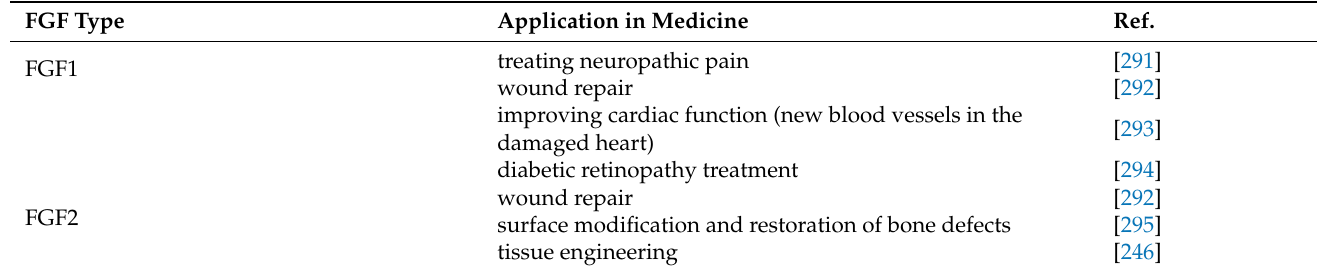
Table 5. The potential application of FGFs in medicine. FGF